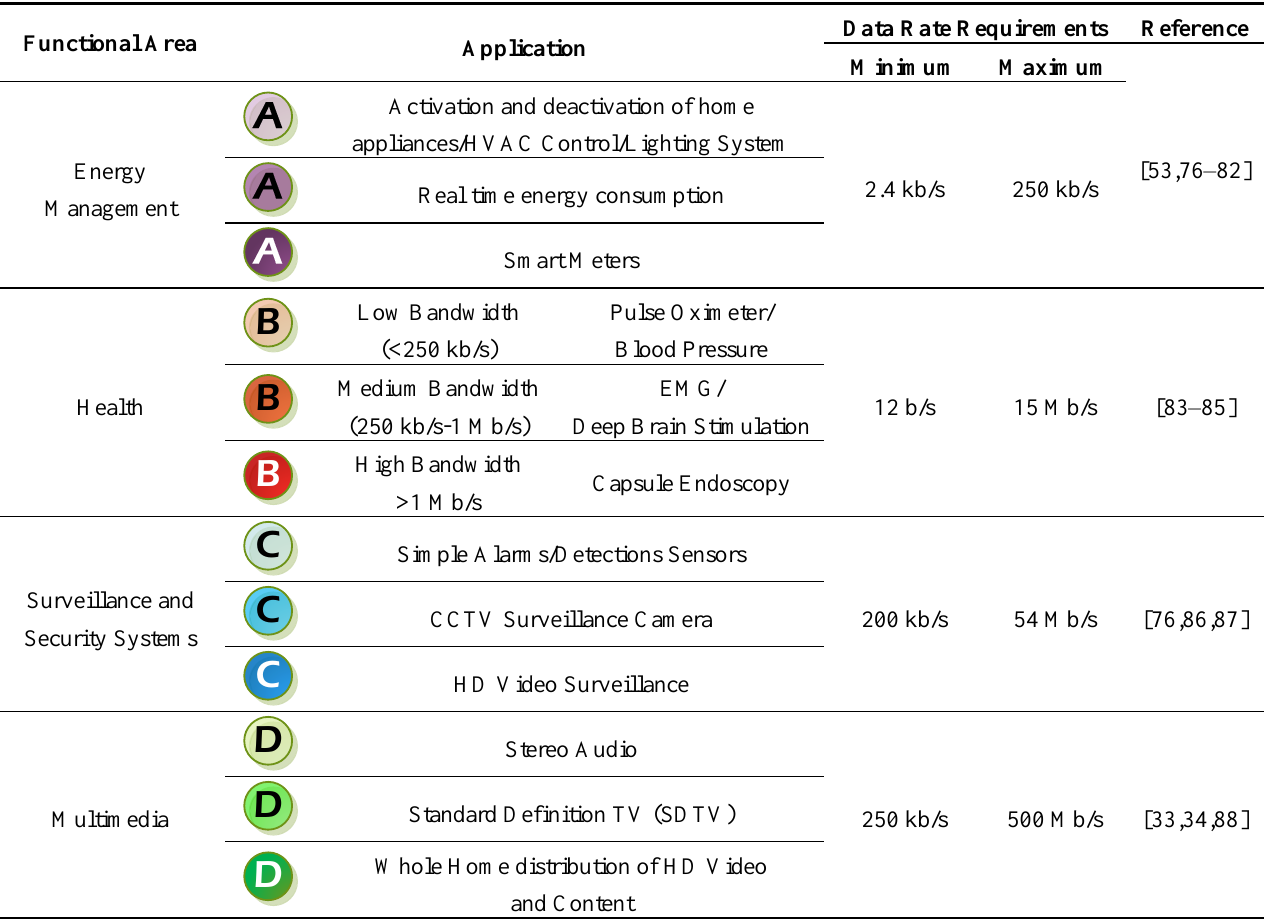
Table 3. Data rate specifications according to application